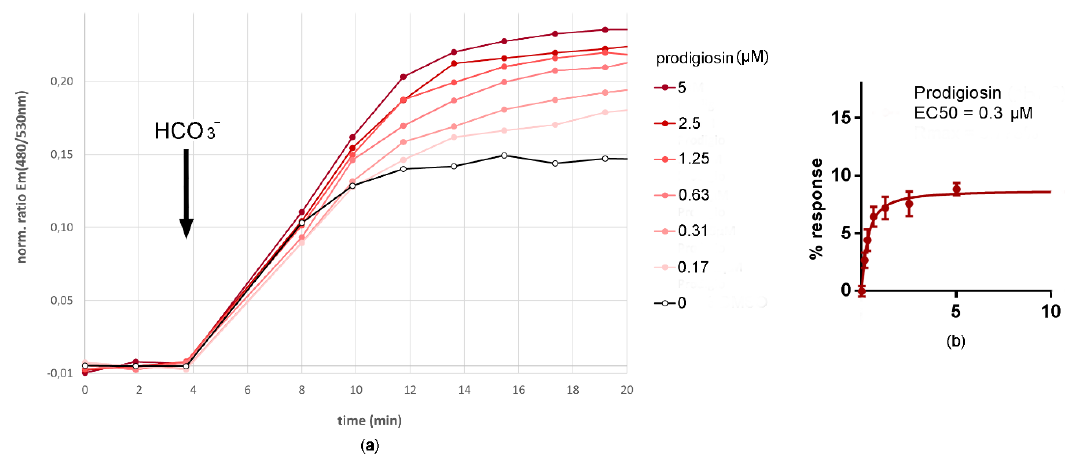
Figure 10. Bicarbonate influx assay—bicarbonate transport activity of prodigiosin. The bicarbonate biosensor cell line measures bicarbonate influx facilitated by the naturally occurring anionophore prodigiosin in a concentration-dependent manner in a range from 0 to 5 µM prodigiosin: Upon addition of 25 µM bicarbonate to the assay buffer, an intracellular increase in bicarbonate concentration facilitated by prodigiosin caused an intracellular increase in cAMP catalyzed by sAC tr . ( a ) This resulted in an increase in the fluorescence emission ratio Em(480 nm/530 nm) when exited at 430 nm in the bicarbonate sensor cell expressing both, the sensory unit sAC tr and the reporting unit CEPAC of the bicarbonate sensory cellular test system. ( b ) A 4-parameter sigmoid concentration-response curve was generated from the percentages of changes in fluorescence emission ratio relative to the control without prodigiosin 14 min after bicarbonate addition. From this concentration-response curve, the EC50 value for prodigiosin was calculated to be 0.3 µM. Data are expressed as mean (n = 6). Error bars represent the mean standard deviation.